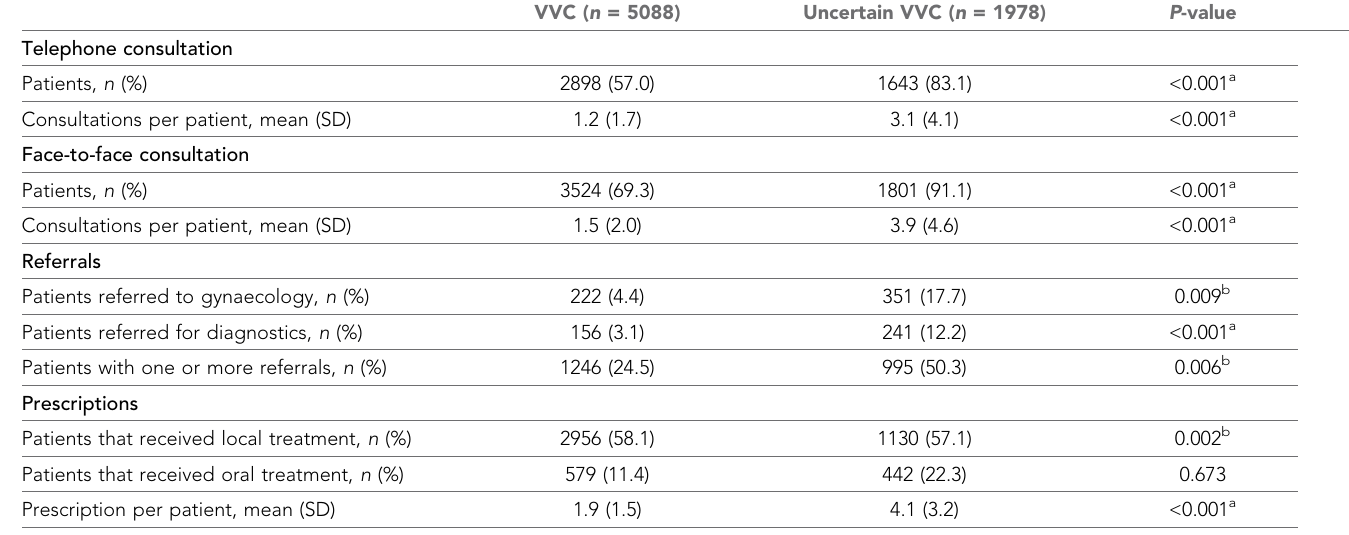
Table 2. Consultations, referrals, and prescriptions related to the disorder in patients with vulvovaginal candidiasis (VVC) and uncertain